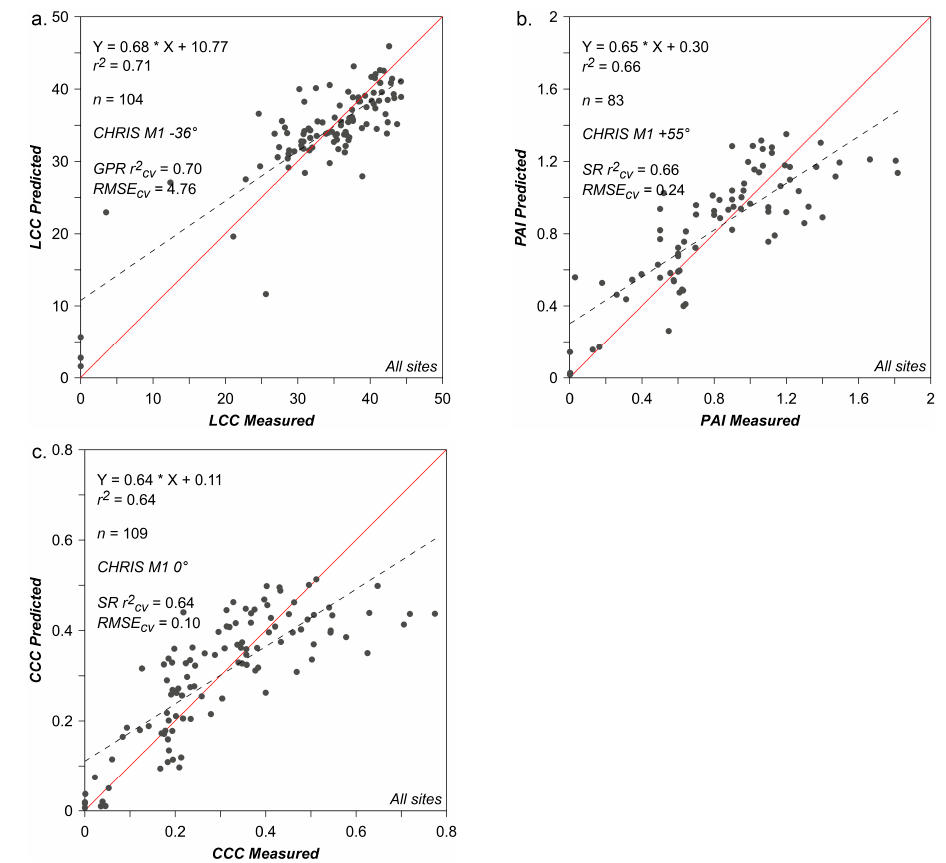
Figure 7. Comparison of Gaussian processes regression (GPR) modelling retrievals for ( a ) leaf chlorophyll content (LCC, μ g/cm 2 ), ( b ) plant area index (PAI, m 2 /m 2 ), and ( c ) canopy chlorophyll content (CCC, g/m 2 ) for combined field sites (global model) using the best fitting models. GPR retrievals for LCC were best for the − 36° view zenith angle (VZA), +55° VZA for PAI, and 0° VZA for CCC. The 1:1 identify line (red) is shown in each scatterplot to provide a comparative reference.